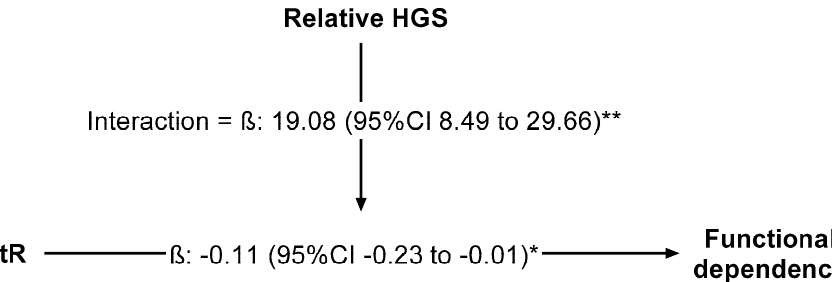
Figure 1. Moderation models. Beta expressed as unstandardized regression coe ffi cients and 95% confidence interval. Because there was substantial covariance between strength capacity and body mass—and, moreover, the links between muscle strength and both physical function and chronic health were mediated by the proportion of strength relative to body mass—grip strength (HGS) was relative as strength per body mass (i.e., (HGS in kilograms) / (body mass in kilograms)). Moderation analysis in which relative handgrip strength moderate the relationship between waist-to-height ratio (WHtR) and functional dependence, adjusted by age, gender, and lifestyle (alcohol intake, smoking, and physical activity “proxy”); * p < 0.01; ** p <